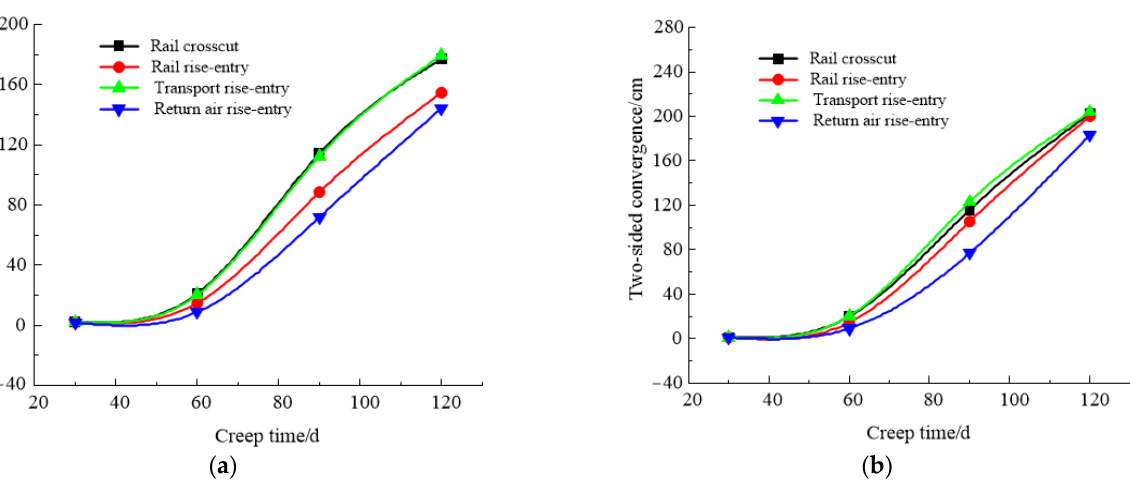
Figure 16. Monitoring results of convergence in roadway-concentrated areas under different creep time conditions. ( a ) Roof-to-floor convergence, ( b ) Two-sided convergence.